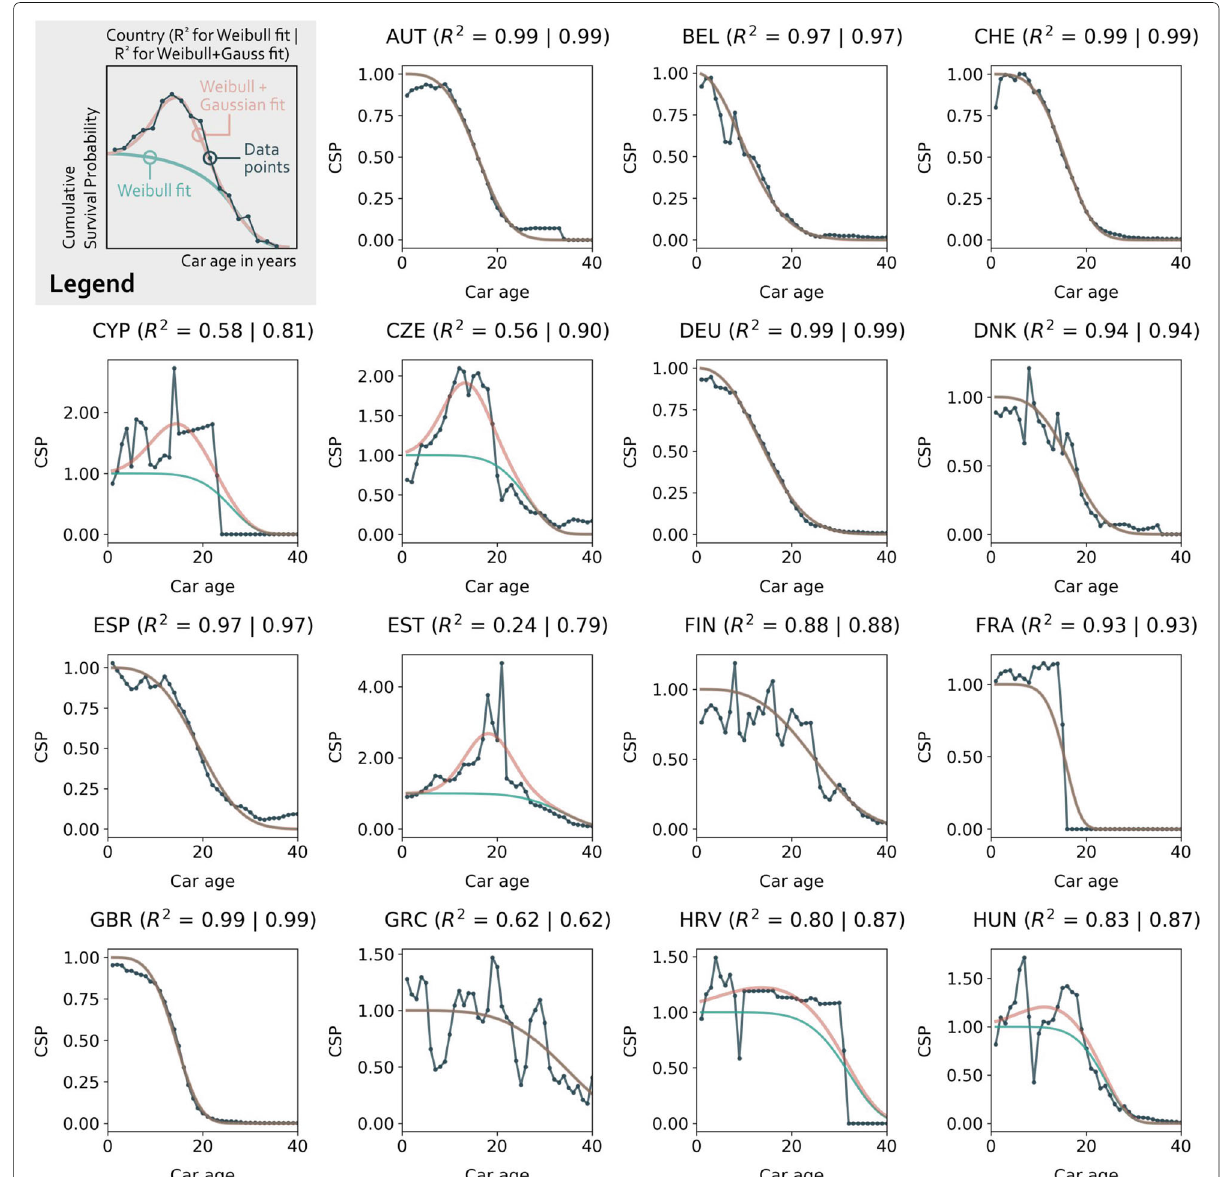
Fig. 2 Cumulative survival probability (CSP) data for European countries (1/2). A Weibull curve (turquoise) and the sum of a Weibull and a Gaussian curve (red) are fitted to the data (dark